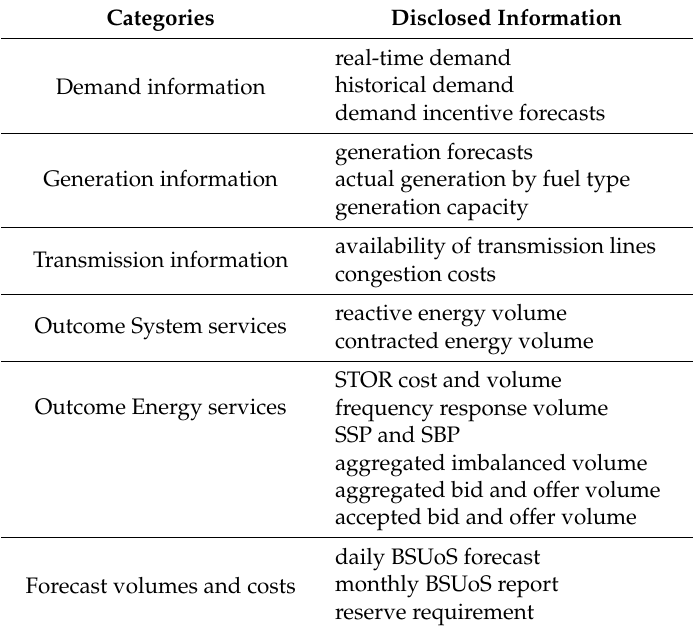
Table 4. List of information disclosed in BETTA